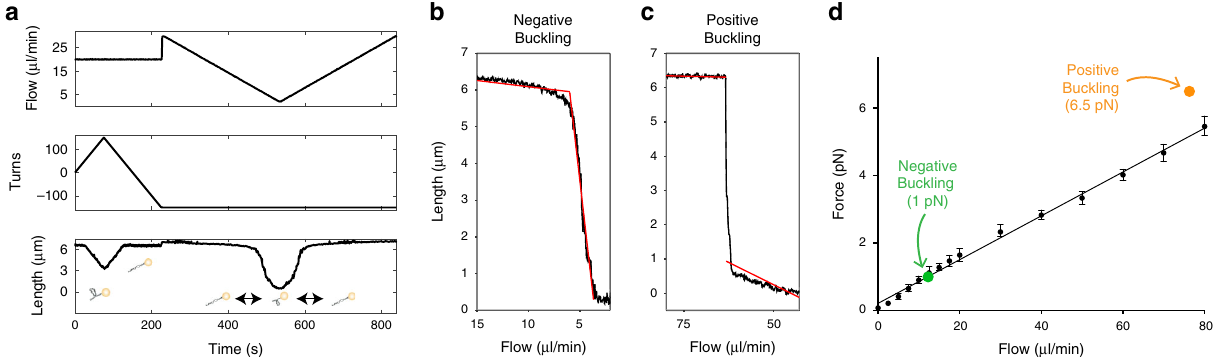
Fig. 3 Force determination. a A fl ow ramp experiment to determine the fl ow rate where negative buckling occurs. The molecule is singly-tethered and negatively supercoiled at high fl ow rate (middle panel). The fl ow is decreased gradually (upper panel) and a buckling transition is seen in the lower panel. b , c Two-segment kinetic change point fi ts to determine buckling fl ow rates for b negative buckling and c positive buckling transitions. d The force increases linearly as a function of fl ow (black points represent the median force). Error bars represent s.e. median. The median negative buckling transition fl owrate from a single experiment is indicated in green (s.e. median is within the spot size) ( n = 399 molecules). The median positive buckling transition from a single experiment is indicated in orange (s.e. median is within the spot size) ( n = 260 molecules). The positive buckling transition is strongly dependent on torque. The measurement was conducted at 150 turns corresponding to a sigma of 0.075. The forces for each buckling transition were set to values from the literature for similar buffer conditions 19 (1 pN for negative buckling and 6.5 pN for positive buckling).